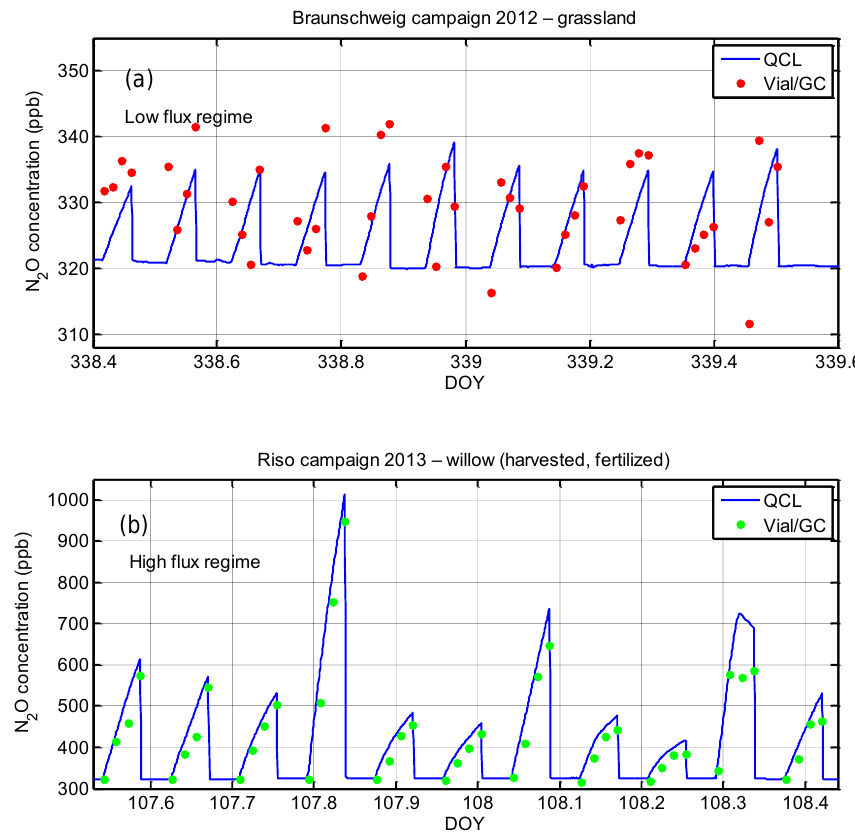
Figure 2. Examples of time series of N 2 O chamber concentrations during the Braunschweig (a) and Risø campaign (b) . Chambers were periodically closed for 60min. Vials were filled with sample air at t 0 , t 20 , t 40 , and t 60 . The QCL system was operated at a sampling frequency of 10Hz; plotted are 1min